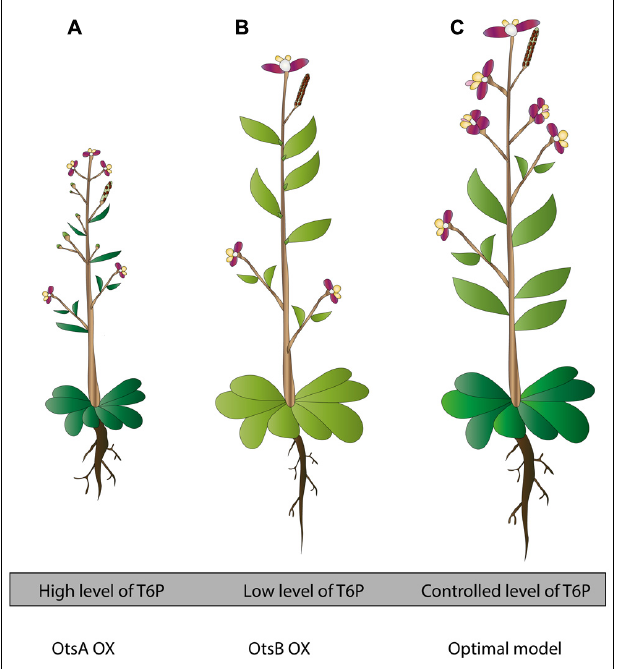
FIGURE 1 |Transgenic plants in trehalose metabolism: toward an optimized approach for stress tolerant plants. (A) OtsA OX plants contain high levels ofT6P.They develop poor seed set, experience reduced apical dominance, flower early and display reduced rosette and darker, lancet shaped leaves. In tobacco OtsA OX, root development is disturbed, showing thicker roots. In Chinese cabbage plants OtsA OX, thicker roots, well developed lateral roots and extensive root hairs were noticed. In general, these plants are better stress tolerant (based on Goddijn etal., 1997; Park etal., 2003; Schluepmann etal., 2003). (B) OtsB OX plants contain low levels ofT6P.These plants show opposite phenotypes to (A) . They develop plenty of seeds, they have distinct apical dominance, flower later, and they have a larger, paler-green rosette (based on Schluepmann etal., 2003). (C) Model for optimized transgenic trehalose metabolism plant.This plant has a controlled cellular level ofT6P.This optimized model is the result of many factors; use of bifunctional constructs, use of condition specific promoters (for instance stress specific, depending on the destined region where the crop will be grown), use of cell-specific promoters (for instance in stomata, usingTRE1 as target gene). In addition, this plant contains optimized constructs, yet unrevealed, connected to abiotic stress tolerance via trehalose metabolism. Ideally, this plant will be